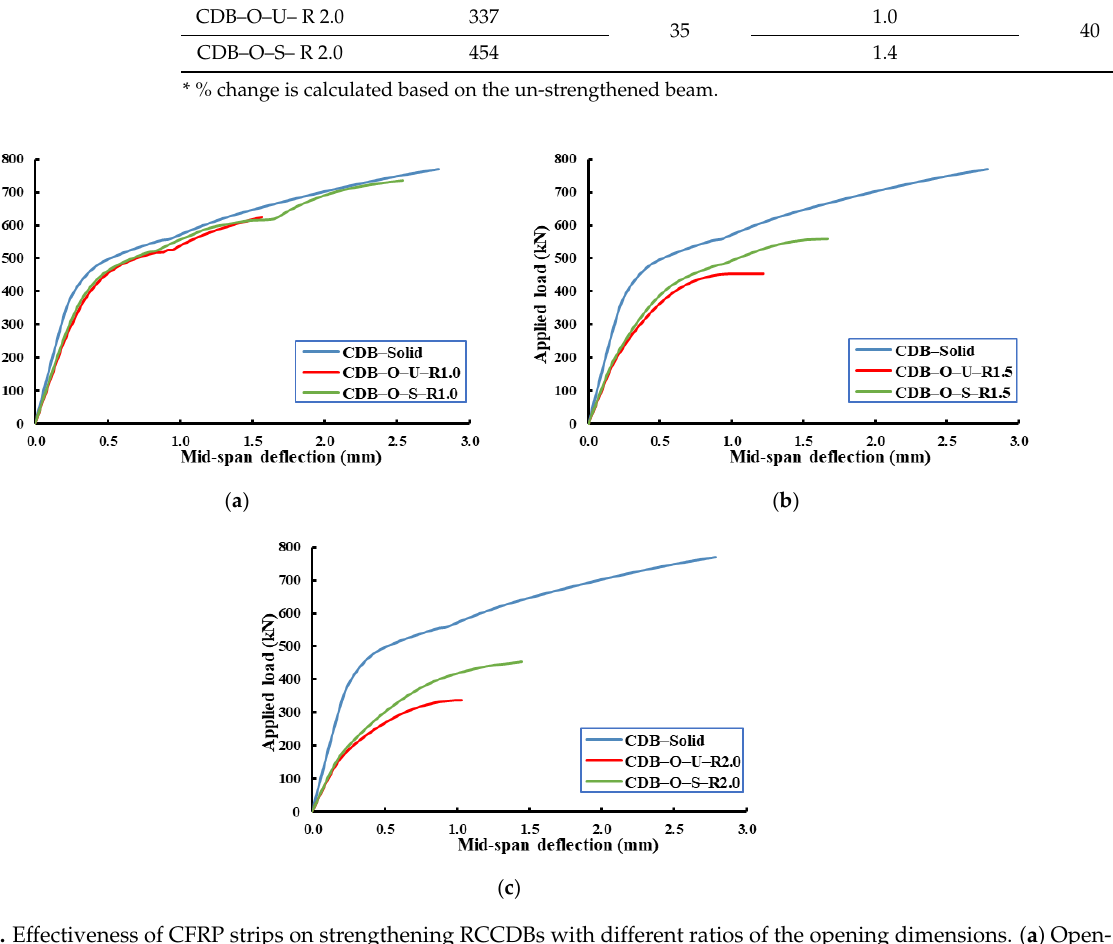
Figure 14. Effectiveness of CFRP strips on strengthening RCCDBs with different ratios of the opening dimensions. ( a ) Opening ratio of 1.0; ( b ) opening ratio of 1.5; ( c ) opening ratio of 2. Table 7. Ultimate capacities and mid-span deflections of RCCDBs with different ratios of the opening dimensions.